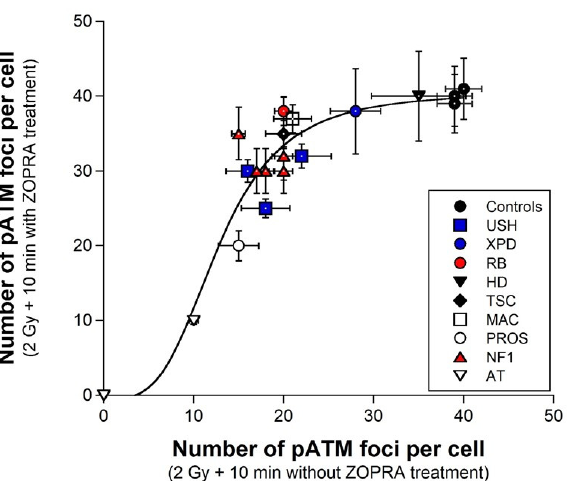
Figure 7. Radioprotective effect of ZOPRA in fibroblasts from 10 genetic syndromes with pATM foci. The number of pATM foci assessed at 10 min post irradiation (X-rays) with and without ZOPRA pretreatment were plotted together. Fibroblasts were derived from the indicated syn- dromes: Usher’s syndrome (USH), PROS syndrome (PROS), McCune–Albright syndrome (MAC), retinoblastoma (RB), Tuberous Sclerosis Complex syndrome (TSC), Huntington Disease (HD), Xe- roderma Pigmentosum D (XPD), Neurofibromatosis 1 (NF1), LIG4 syndrome (LIG4) and ataxia telangiectasia (AT). Note the AT data are obtained from historical data of the N.F. lab; all these data were published elsewhere [31–33,40,41,48–50]. Each point represents the mean ± standard error (SEM) of at least three replicates. Data were fitted to the following sigmoidal function: y = 40.53 + (40.10)/(1 + (x/12.797) 3.51 ); r = 0.944.